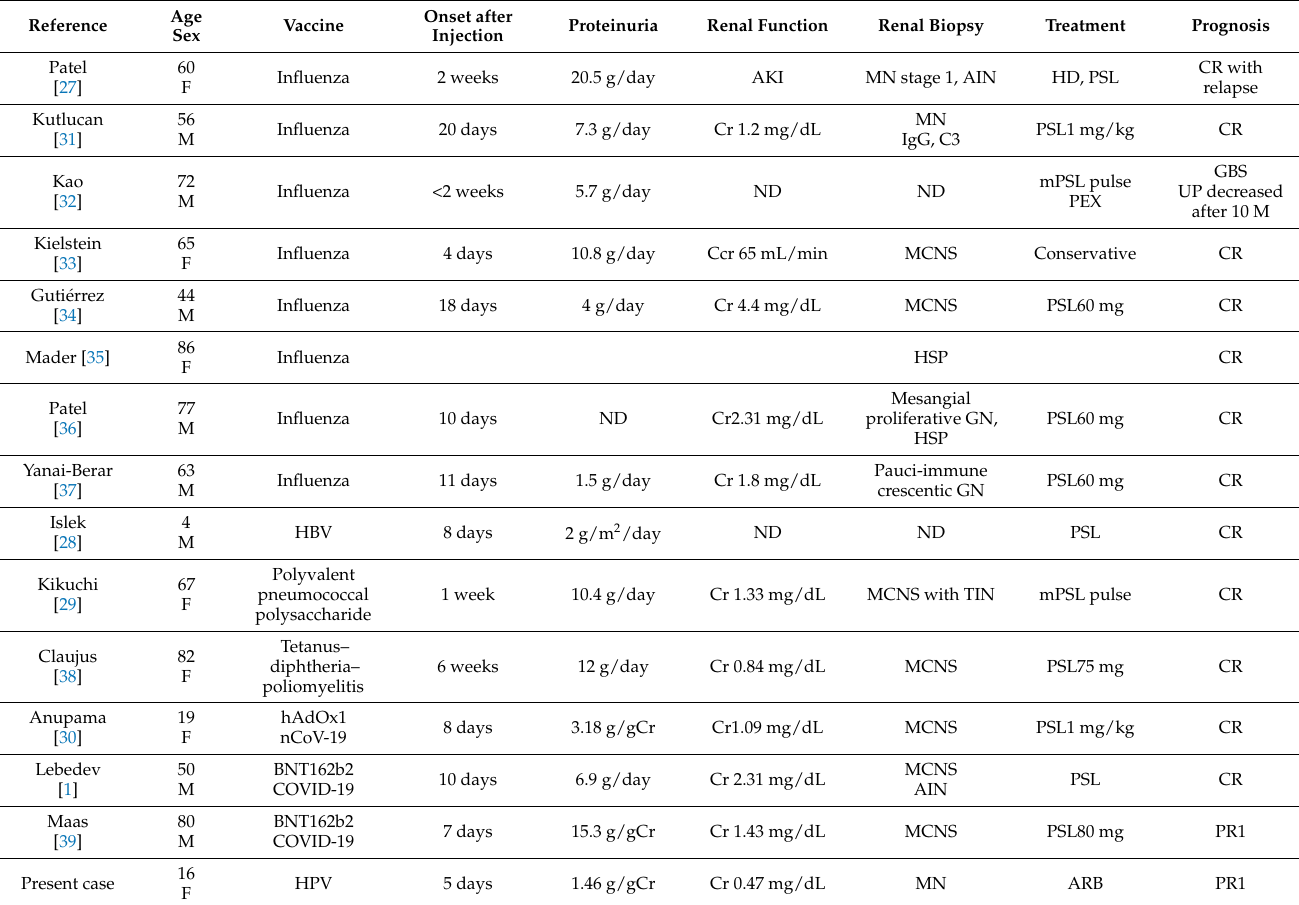
Table 2. Nephrotic syndrome and nephritis associated with